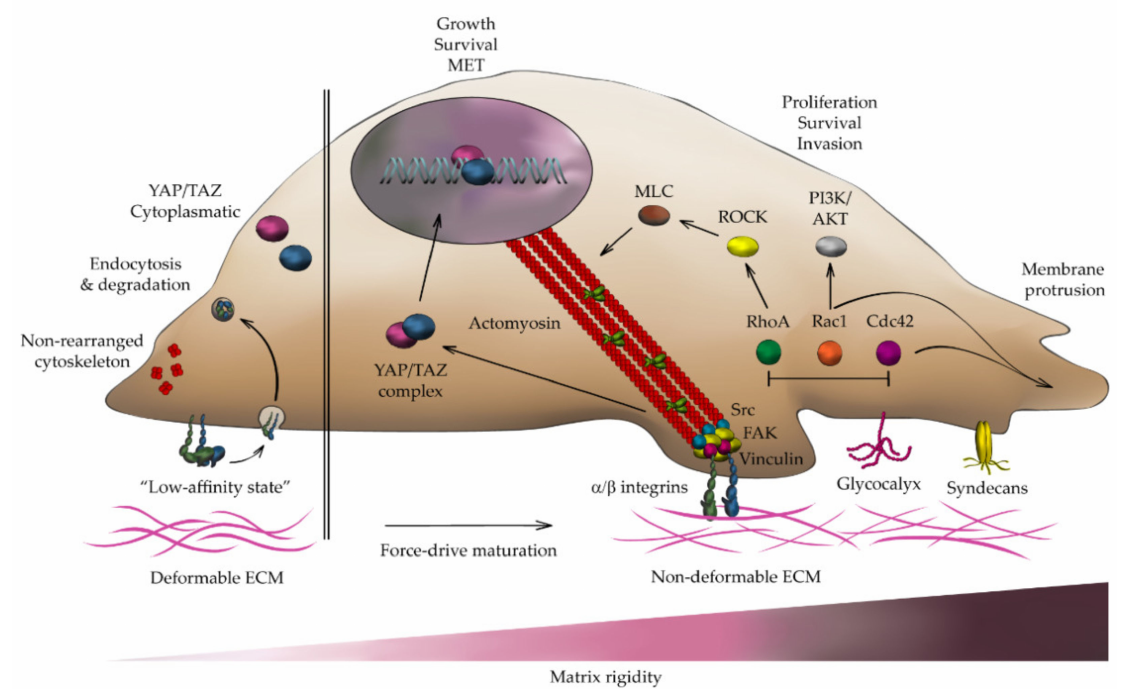
Figure 3. Integrin-dependent adhesion and tensile force mechanotransduction modulate cellular behavior. Cells dynamically probe the biomechanical properties of the surrounding ECM using a host of cell surface receptors including, integrins and syndecans, and activate intracellular signaling pathways accordingly. Soft substrates are not strong enough to activate integrin-mediated signaling and the subsequent mechanotransduction of tensile forces. Consequently, integrins exhibit a low-affinity configuration that hinders either the stabilization of FAs or the actin cytoskeleton rearrangement. In fact, the softness of the matrix elicits the endocytosis and degradation of integrins, enhancing this effect. In contrast, rigid substrates promote integrin recruitment and their effective anchoring to the ECM in a stiffness-dependent manner. Likewise, the cell glycocalyx is compressed by the ECM fibers, which mechanically stresses the integrins, upregulating their activation. Accordingly, integrin activation triggers vinculin coupling and the subsequent activation of the focal adhesion kinase (FAK)/Src complexes that stabilize the FA clutches. Mature FAs bind to actomyosin machinery to sustain the contractile forces required during cell spread. Similarly, syndecan-matrix interaction can activate myosin II to promote cell contractibility and migration in a feedforward positive loop. The mechanotransduction of ECM-derived tensile forces also promotes the YES-associated protein (YAP)/TAZ complex translocation into the nucleus, which triggers the transcription of many oncogenes involved in MET processes. On the other hand, FAK/Src produces downstream signaling events, regulating the activity of Rho GTPases. The crosstalk between RhoA and Rac1 controls the mechanosensitivity of the ECM and provides high cellular plasticity to adapt cell ´ s mechanobiology to the ECM properties. Indeed, RhoA activates ROCK-signaling concomitant with MLC activation, which stimulates actomyosin contractility and FA assembly. In parallel, the expression of Rac1 and Cdc42 at the leading edge induces the extent of actin-rich membrane protrusions -i.e., lamellipodia and filopodia- promoting directed cell migration. Furthermore, FAK-mediated signaling also promotes pro-survival and invasiveness signals via Rac1/PI3K/AKT pathway. Therefore, the biomechanical properties of the ECM largely determine efficient integrin-dependent adhesion and stress mechanotransduction, which stimulate Rho GTPase signaling and trigger oncogene transcription. Accordingly, these events modulate cell behavior, favoring tumor cell transformation and proliferation, survival, and/or invasion